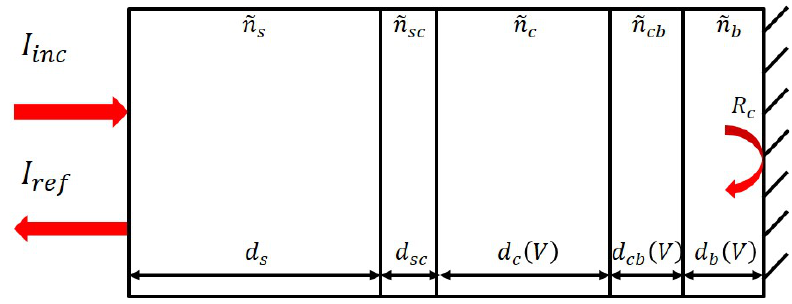
Figure 4. Simplified reverse biased diode structure for the